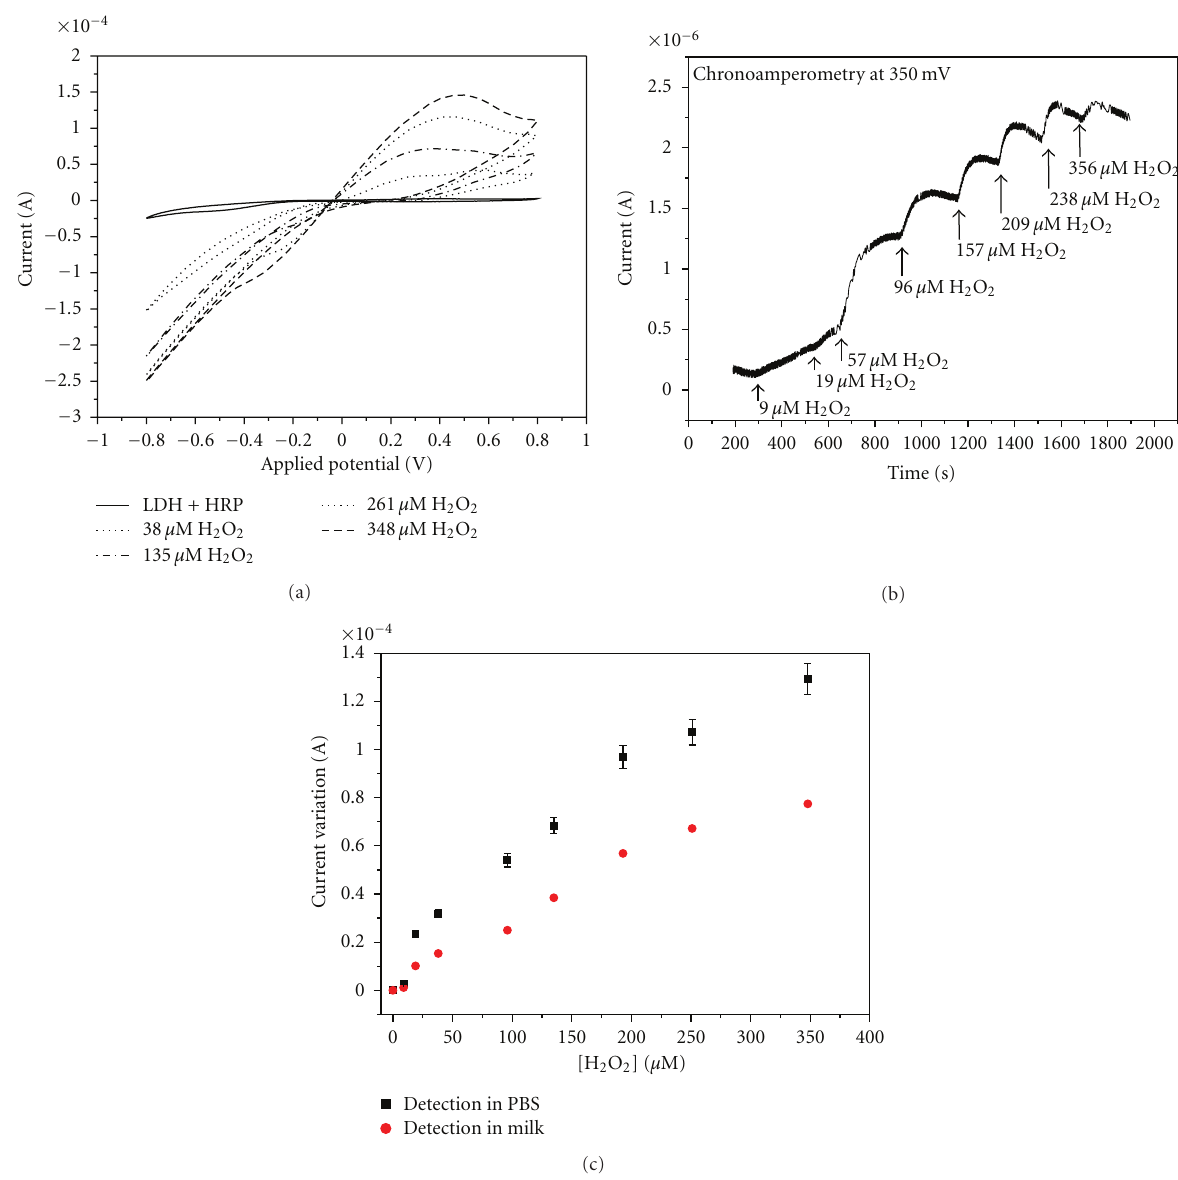
Figure 3: (a) Cyclic voltammogram of gold electrode functionalized with HRP before and after the injection of di ff erent H 2 O 2 concentration. (b) The chronoamperometry curve of functionalized gold electrode with HRP at a fixed potential of 350 mV after H 2 O 2 injections. (c) Current variation (current after H 2 O 2 injection) of the developed biosensor after di ff erent injection of H 2 O 2 concentration at 350mV obtained from Figure 3(a) in PBS bu ff er and raw milk. Linear regression was observed between 0 and 200 µ